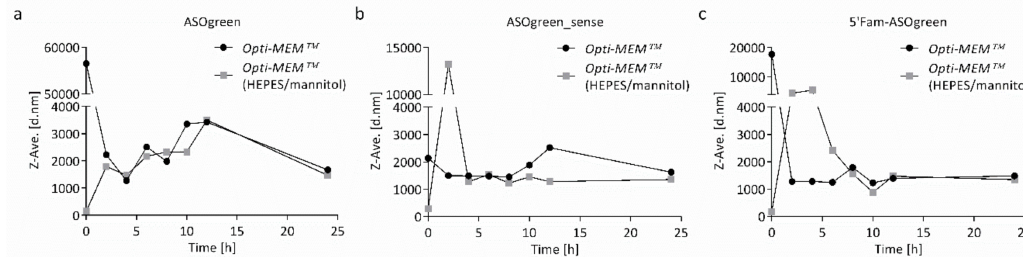
Figure 5. Stability of CS–ASO nanocomplexes in the transfection medium. The stability of CS–ASO nanocomplexes with ( a ) ASOgreen, ( b ) ASOgreen_sense and ( c ) 5 (cid:48) Fam-ASOgreen at a P / N charge ratio of 90 with 85 mM NaCl is shown. Nanocomplexes were incubated in Opti-MEM ™ or Opti-MEM ™ supplemented with HEPES (20 mM) and mannitol (270 mM) at 37 ◦ C. Nanocomplexes in Opti-MEM ™